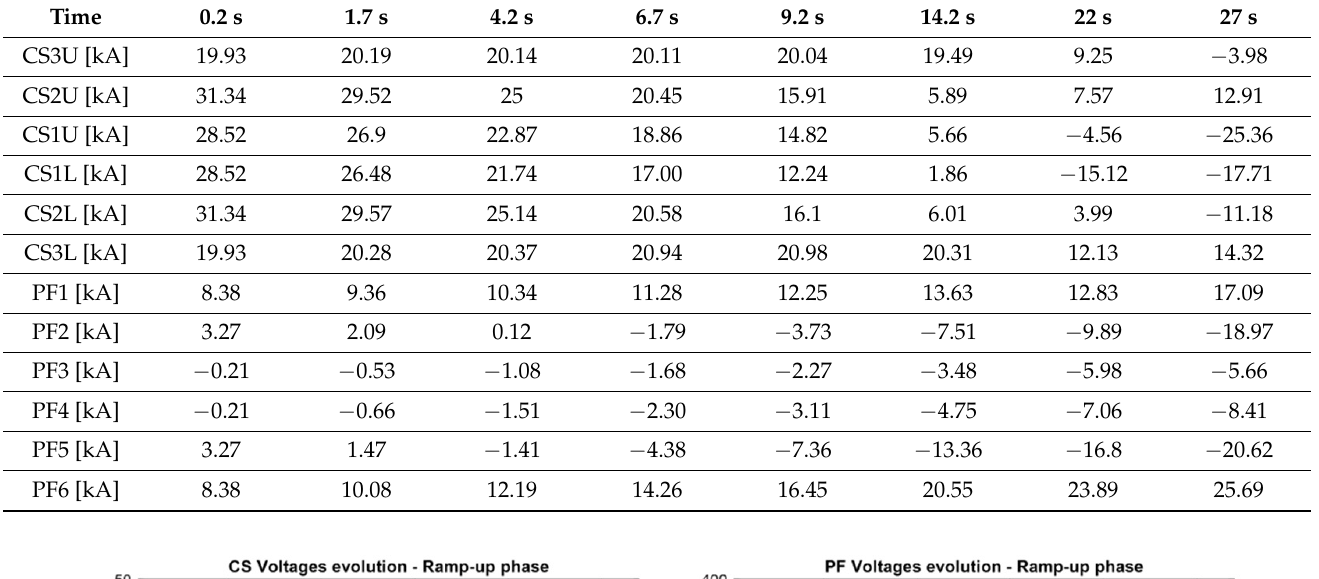
Table 3. Time evolution of CS/PF currents of the SN ramp-up phase with a plasma current rate of 200 kA/s.